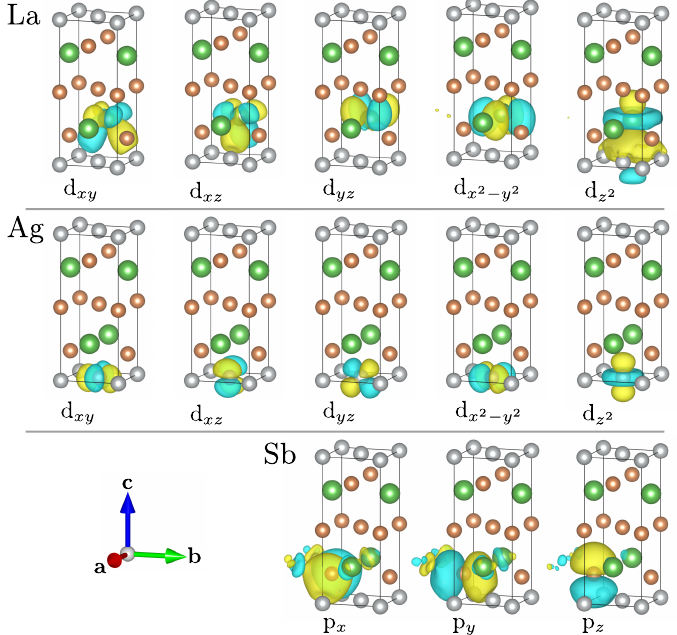
Figure A2. The final form of the maximally localized Wannier orbitals, found during procedure of the DFT band structure wannierization. Groups from top to bottom correspond to d -like orbitals of Ag and La, and p -like orbitals of Sb, as